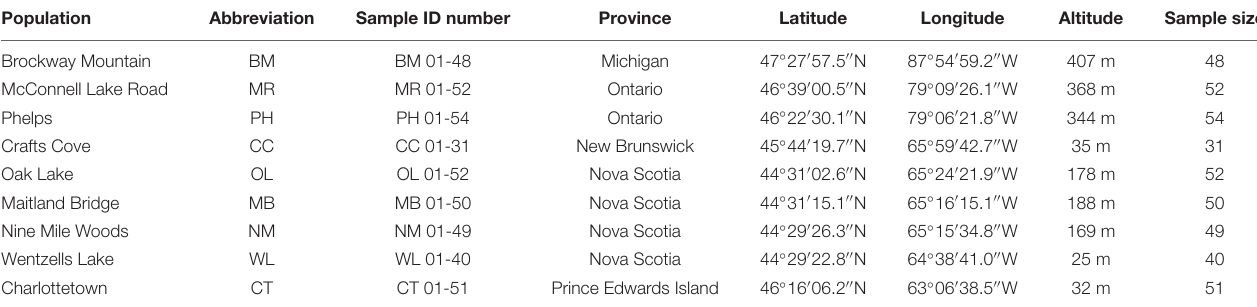
FIGURE 1 | Location and sample size of the northern red oak populations within their natural distribution area (highlighted). BM, Brockway Mountain; MR, McConnell Lake Road; PH, Phelps; CC, Crafts Cove; OL, Oak Lake; MB, Maitland Bridge; NM, Nine Mile Woods; WL, Wentzells Lake; CT, Charlottetown. TABLE 1 | Northern red oak populations sampled, their locations and geographic